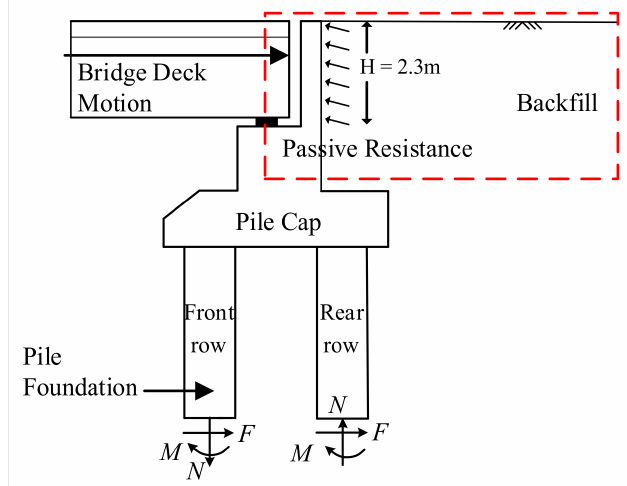
Figure 12. Force on abutment during